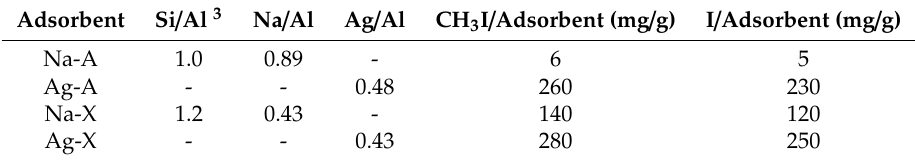
Table 3. Chemical composition 1 and adsorption amounts 2 for the four adsorbents studied here. Adsorbent Si/Al 3 Na/Al Ag/Al CH 3 I/Adsorbent (mg/g)